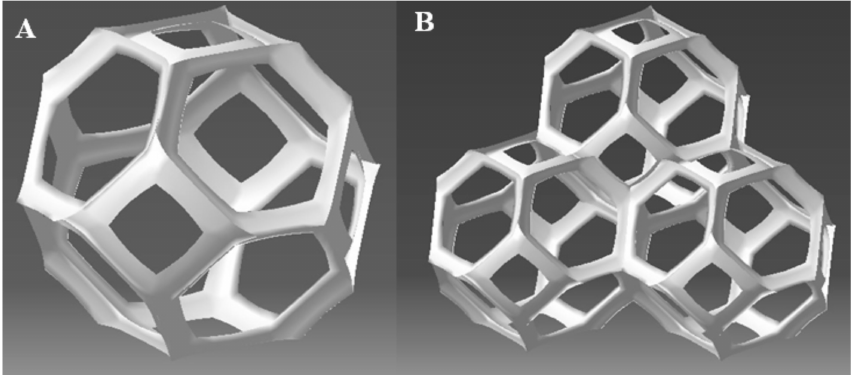
Figure 6. Single TTKD cell ( A ); combined TTKD cells ( B